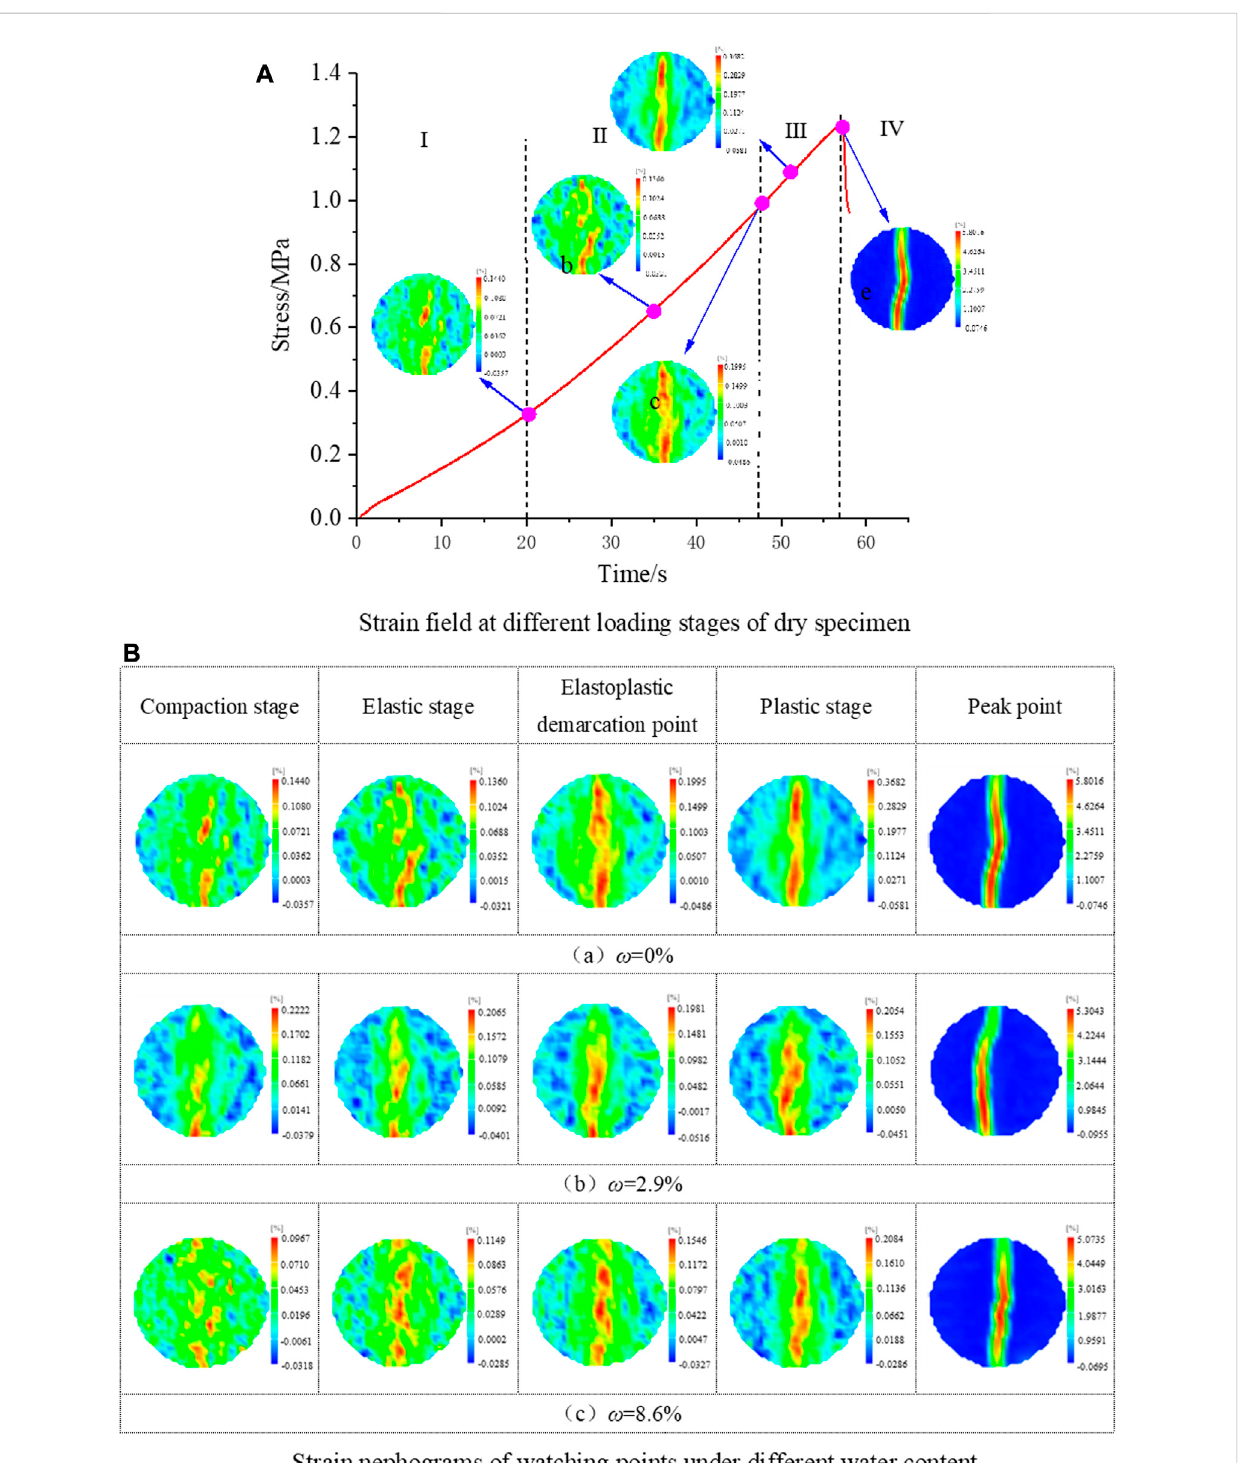
FIGURE 7 Evolution of the horizontal strain in the splitting disc with different water contents. (A) Strain fi eld at different loading stages of dry specimen. (B) Strain nephograms of watching points under different water contents.